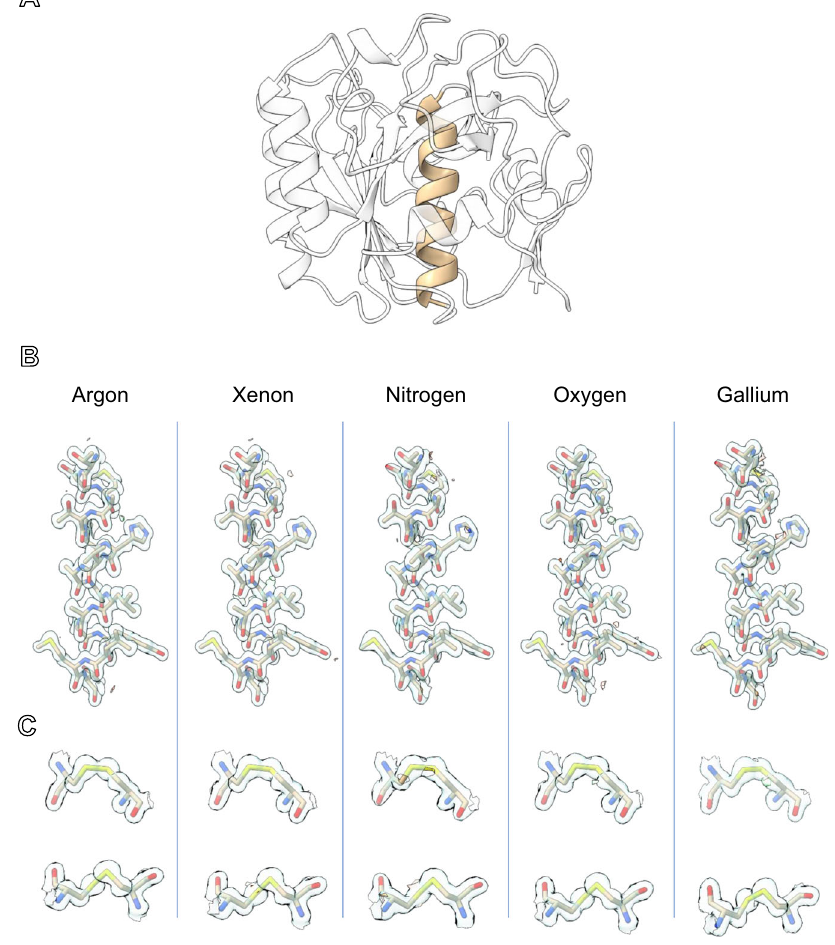
Fig.5|ThestructureofproteinaseKdeterminedfromplasmaion-beammilled lamellae. A The structure of the serine protease, proteinase K, determined by MicroED from plasma ion-beam milled lamellae. B Maps for each plasma source and the prior best gallium structure from the same helix (residues 328 – 344)